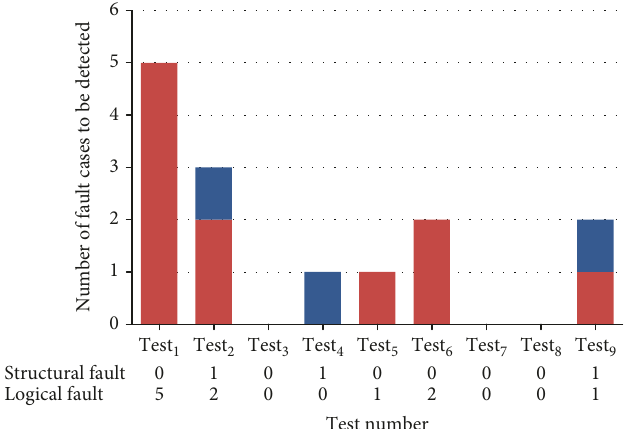
Figure 12: Number of fault cases in